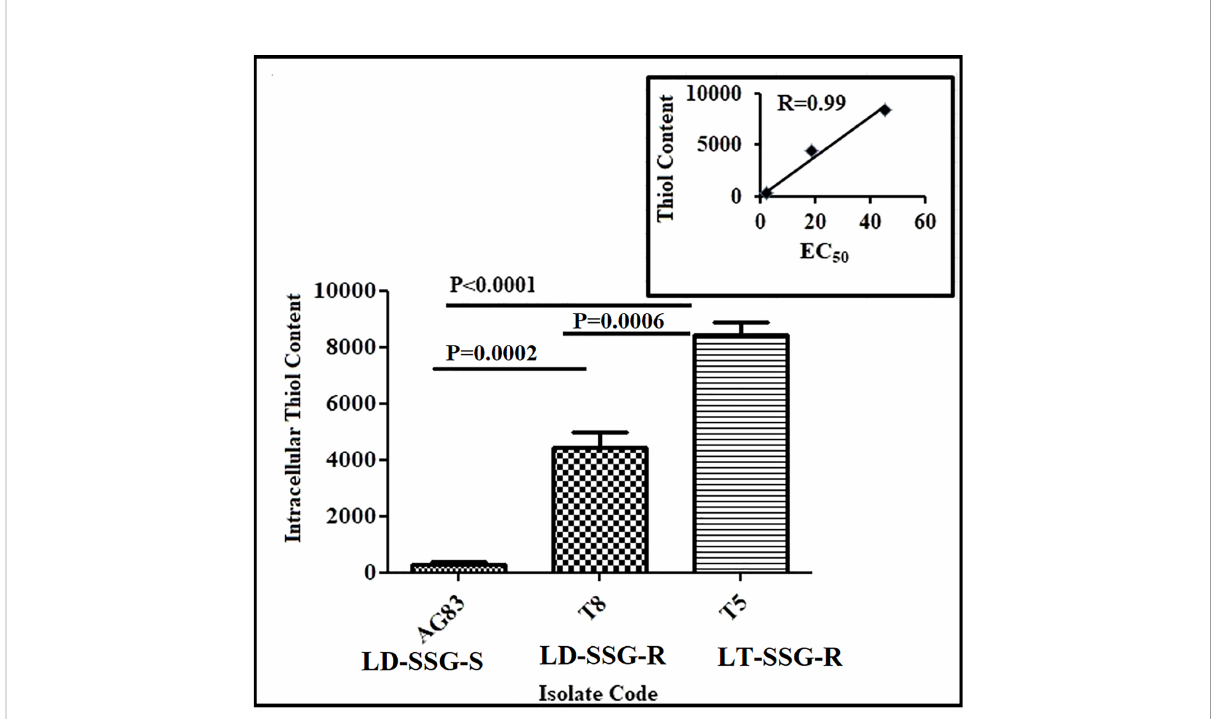
FIGURE 1 Analysis of thiol content in SSG-S (AG83-LD-SSG-S) and SSG-R (T5-LT-SSG-R and T8-LD-SSG-R) Leishmania promastigotes by fl ow cytometry. The thiol content was measured using a fl uorescence probe 5-chloromethyl fl uorescein-diacetate and presented in terms of mean fl uorescence intensity values. The inset shows the scatter plot representing the correlation between EC 50 values against sodium stibogluconate and the intracellular thiol content of each